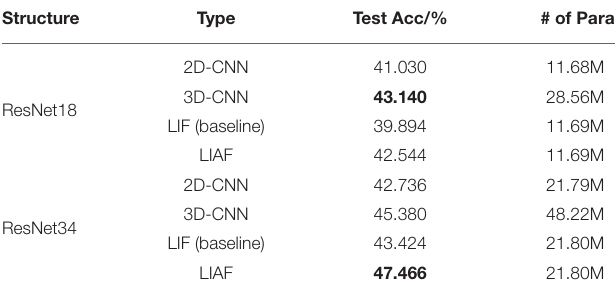
TABLE 4 | Test results &